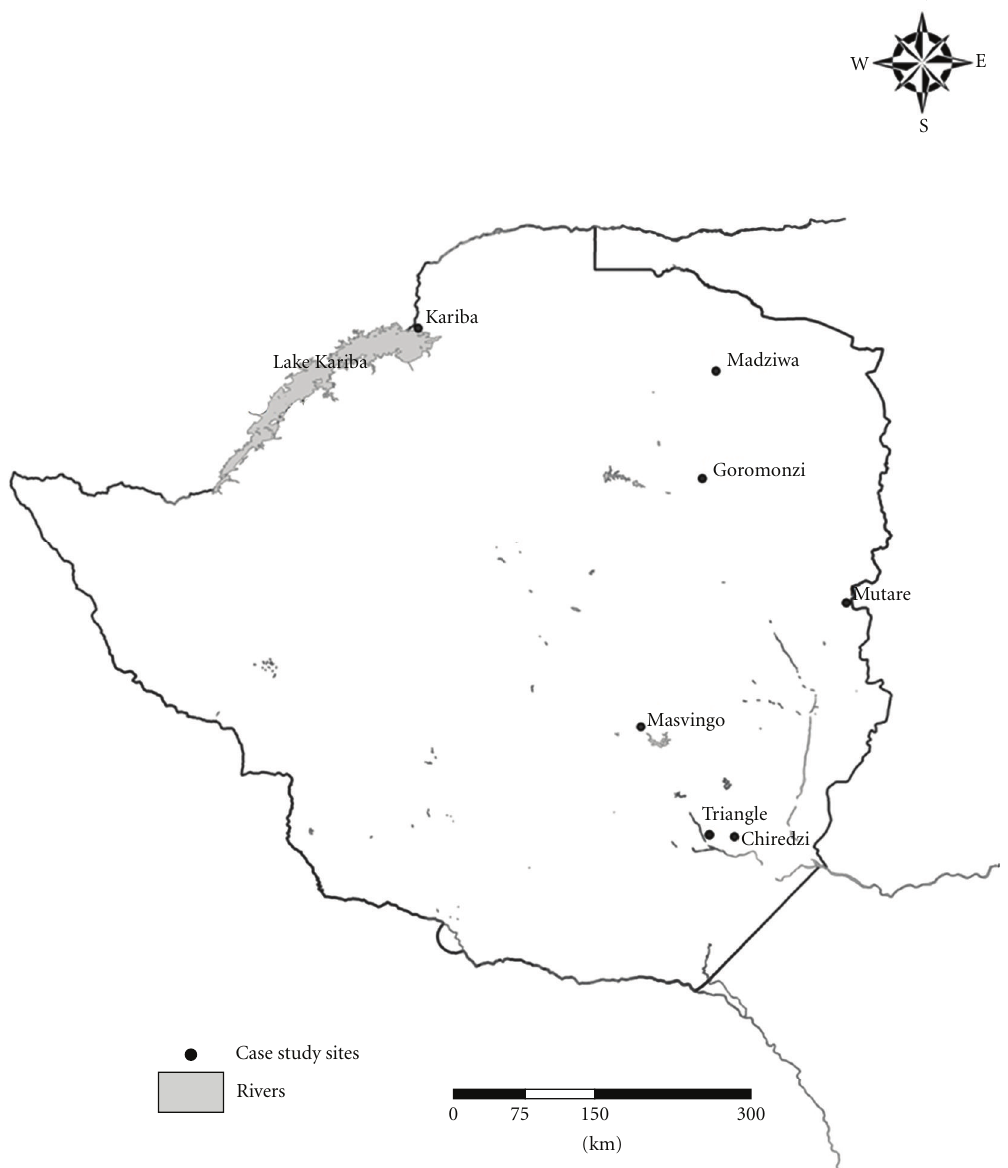
Figure 2: Map of Zimbabwe showing locations of case studies reviewed (produced by Mrs. A. Makati, GIS Laboratory, Okavango Research